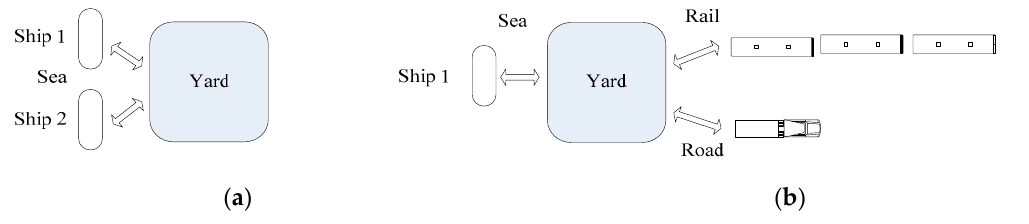
Figure 2. ( a ) Intra-terminal transshipment; ( b ) Inter-modal